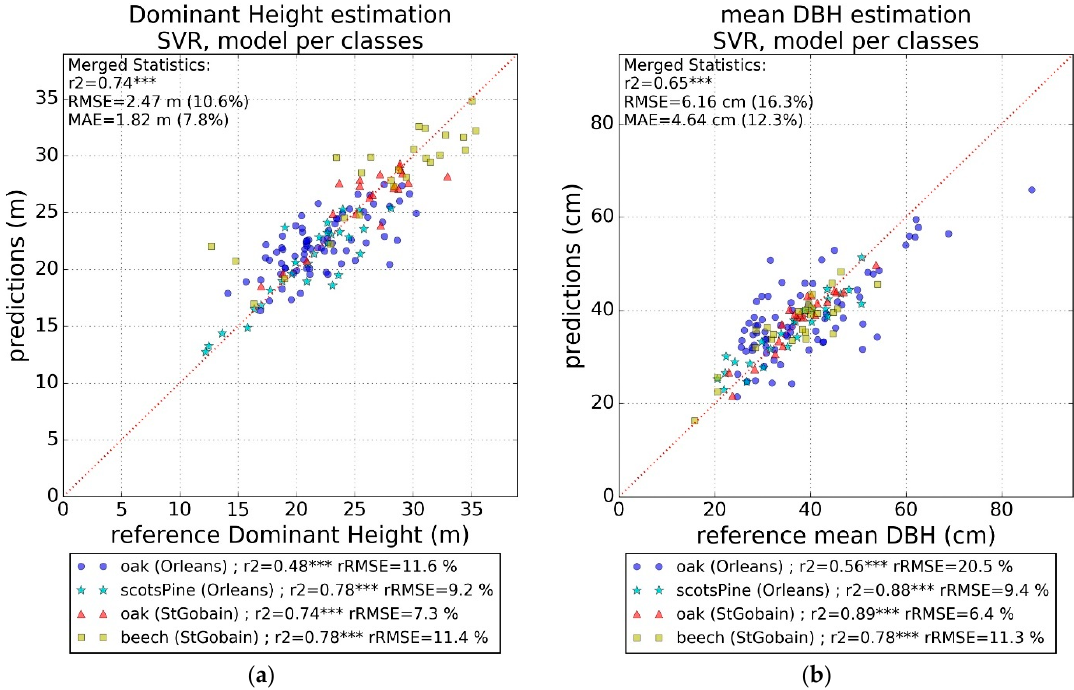
Figure A2. Validation scatterplot forest parameters estimation with ONF field measurements and satellite remote sensing data. ( a ) dominant height (Hdom); ( b ) mean diameter at breast height (DBH). Statistical signicicance: *** p ≤ 0.001.